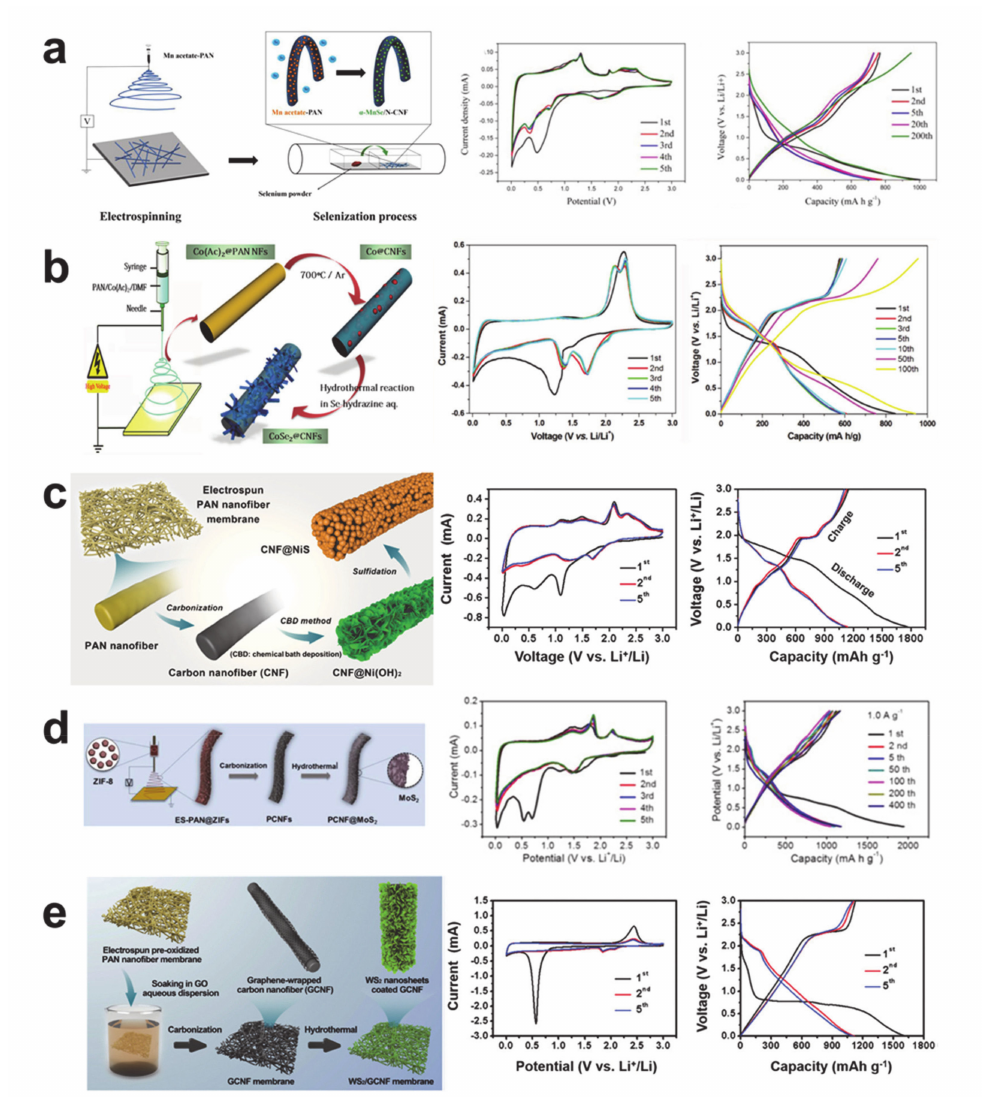
Figure12. Transitionmetalchalcogenideanodematerials. ( a ) α -MnSe /